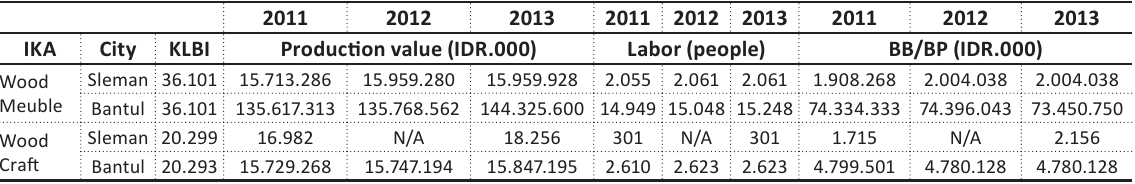
Table 1. Proportion of labor absorption and IKA raw material Production value (IDR.000)